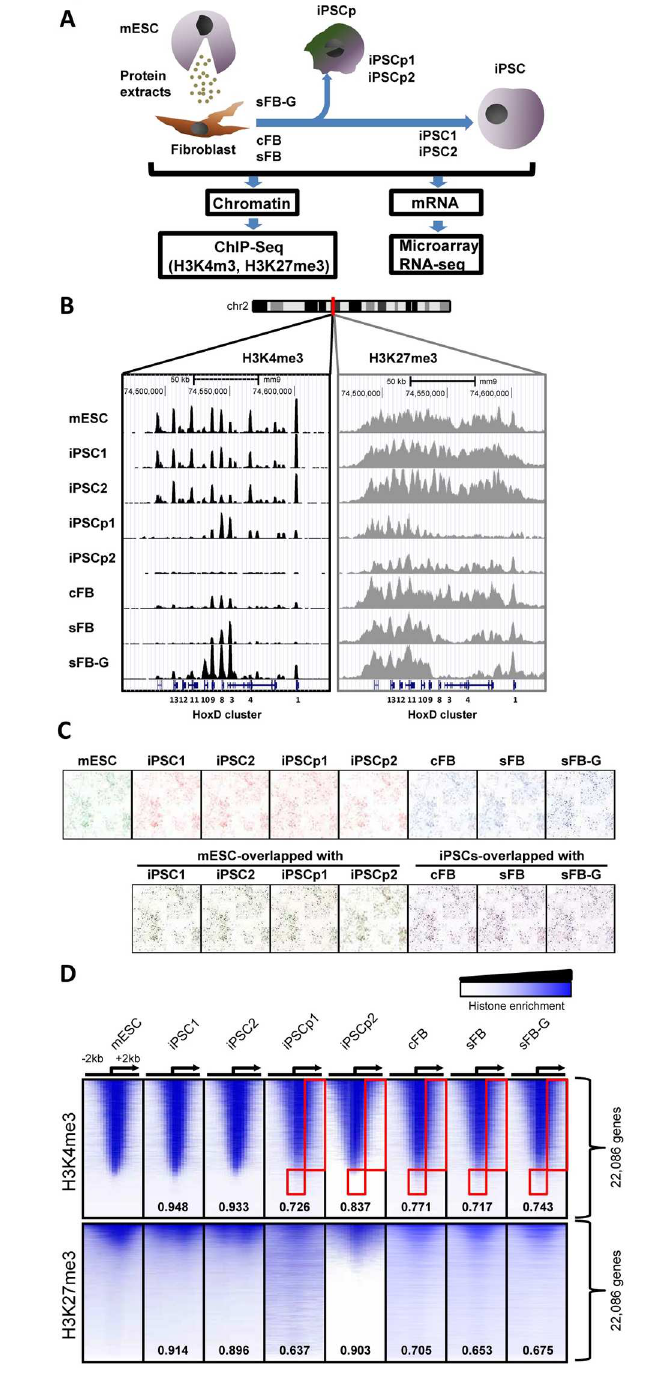
Fig 1. Global histone modification signatures of pluripotent and somatic cells. (A) Experimental overviewof the genome-wide analysisof the histonemodifications of mESC, iPSCs and the originalsomatic cells using ChIP-Seq and their gene expressionmeasuredvia microarray and RNA-seq. (B) The histone modificationprofilesof the Hox D cluster genesare shown using the UCSC genomebrowser. The genomic positionof the regionis indicatedon top of the map. (C) Chromosome-wideH3K4me3peak patterns are comparedin different cells. The Hilbert plots of H3K4me3enrichments at chromosome 1 are visualizedusing the HilberVis program. (D) The comparisonof histonemodificationpatterns between different mESCs and iPSCs. The heatmaprepresents the distributions of the histonemodificationnear the TSS of 22,086RefSeq